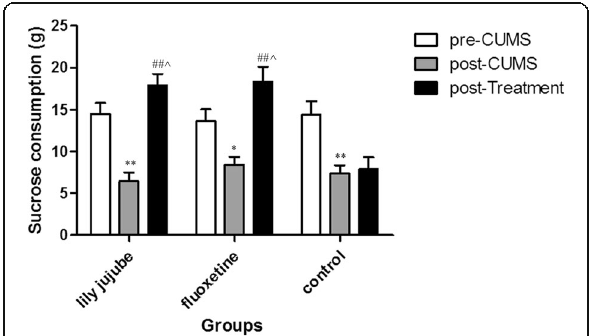
Fig. 4 Changes of sucrose consumption in SCT at different time points.